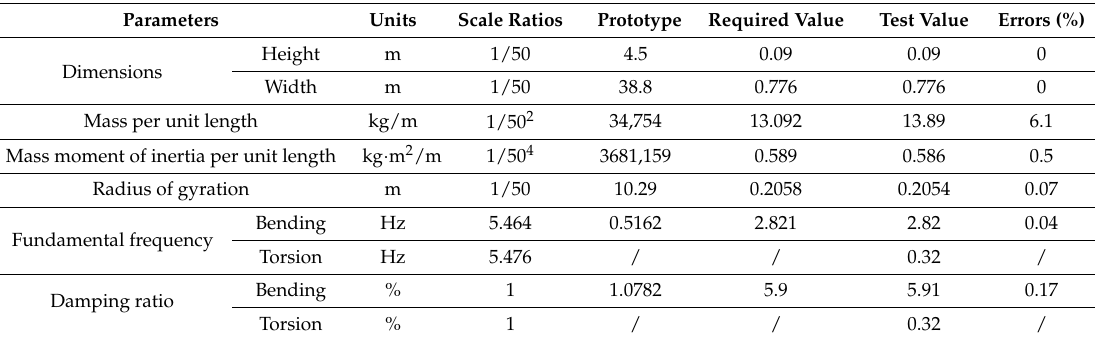
Table 1. The parameters of the test